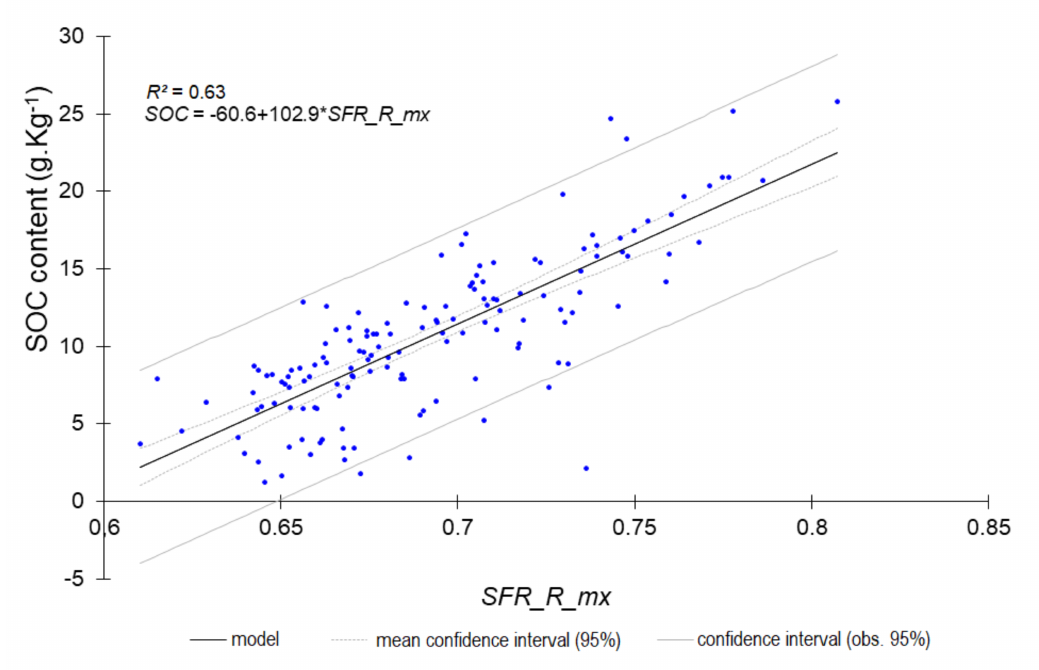
Figure 5. Predicted SOC content from the single SFR_R_mx index (all horizons).